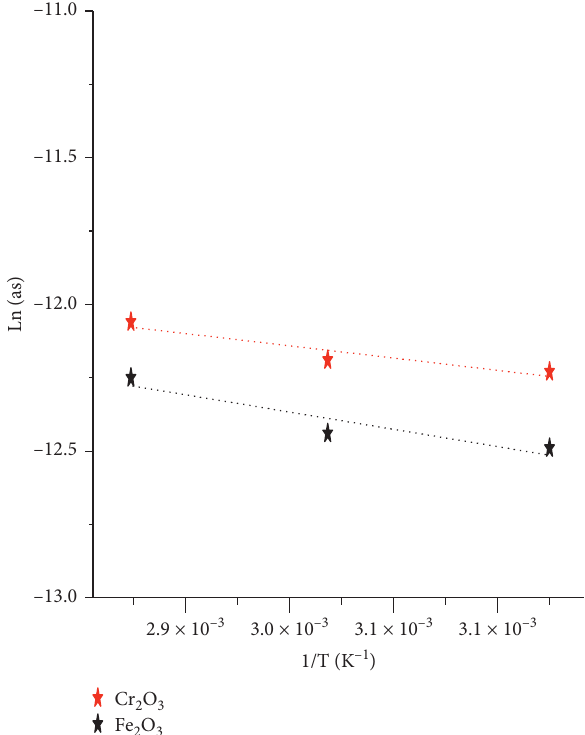
Figure 7: Logarithm of the specific activity versus temperature